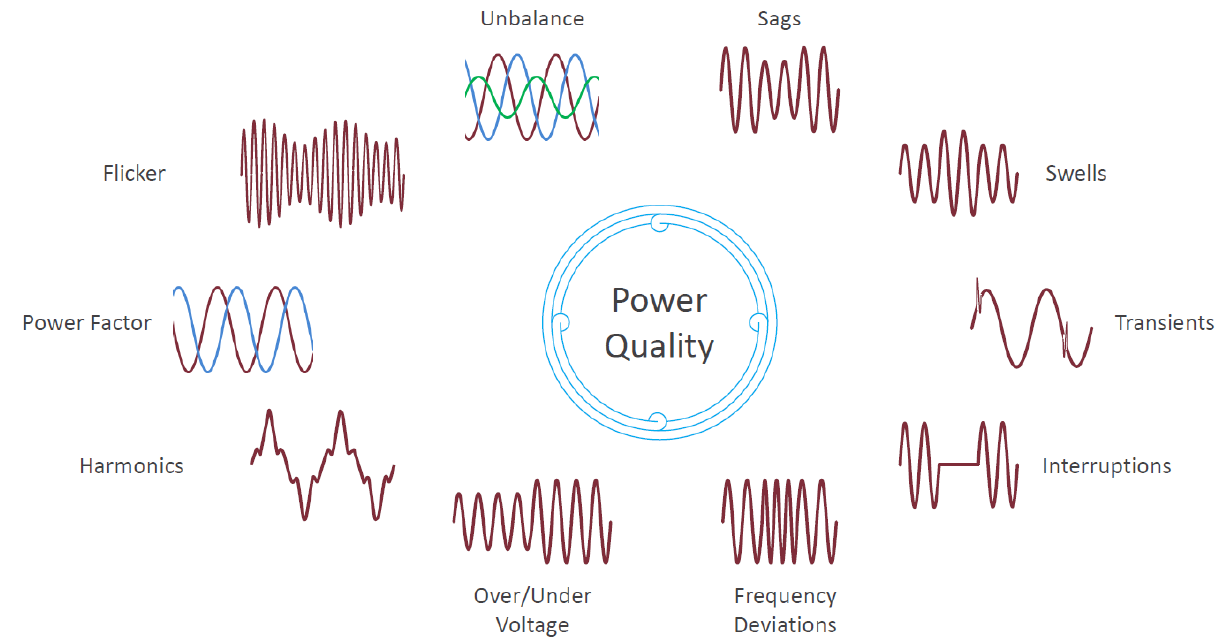
Figure 1. Power Quality from the viewpoint of a power generation and transmission company (Source: Transpower New Zealand).